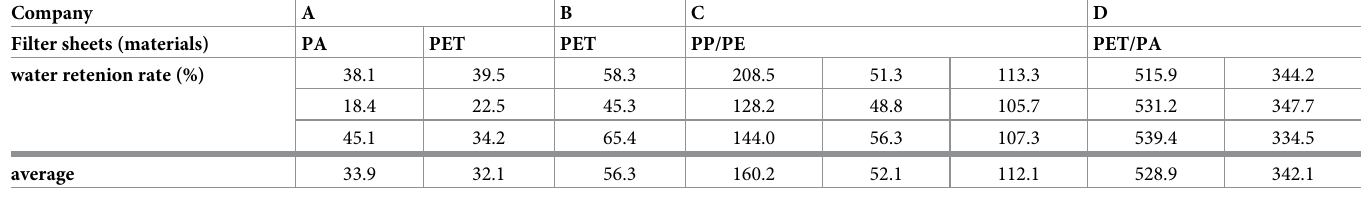
Table 2. Water retention test.